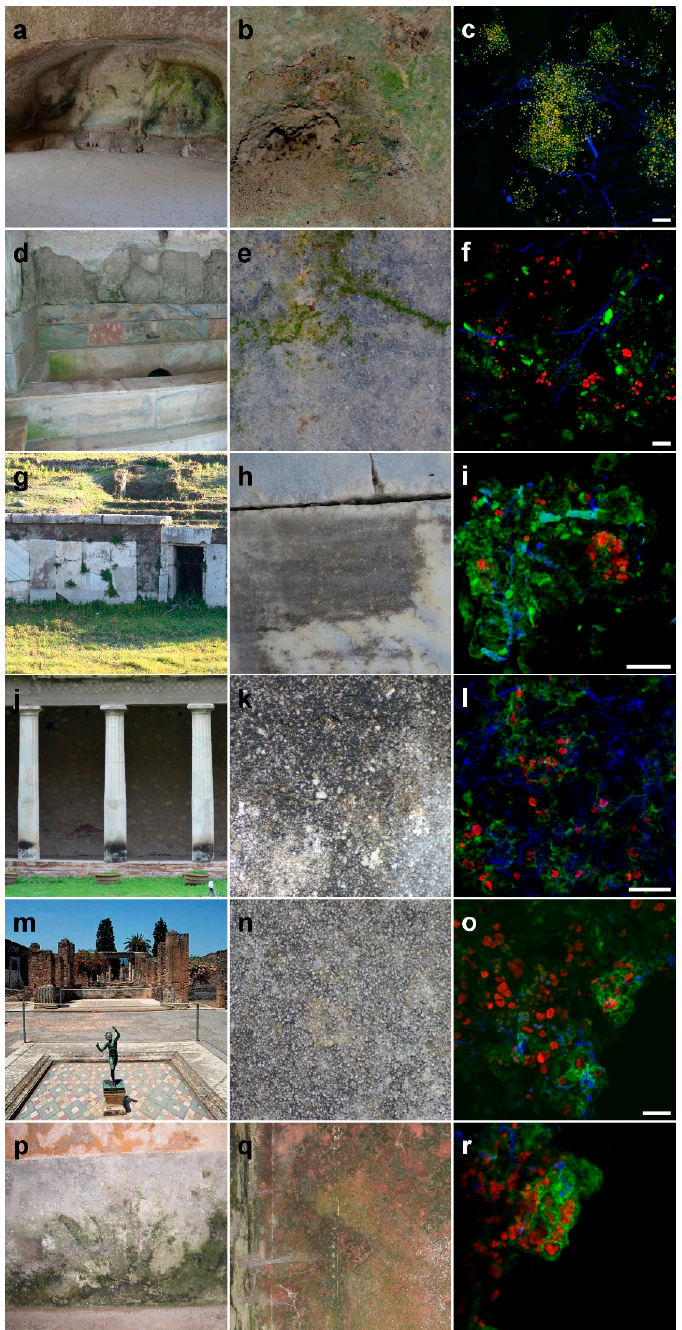
Figure 2. Archeological sites: Sibyl Caves in Cuma ( a ), Suburban Baths in Ercolano ( d ), the Roman Amphitheater in Nola ( g ), the House of Poppea in Oplonti ( j ), and the House of Fauno ( m ) and the House of Castricio ( p ) in Pompei; the visible alteration at the same sites ( b , e , h , k , n , q ); the recorded adhesive tape samples observed on the CLSM ( c , f , i , l , o , r ; scale bar, 50 µm).